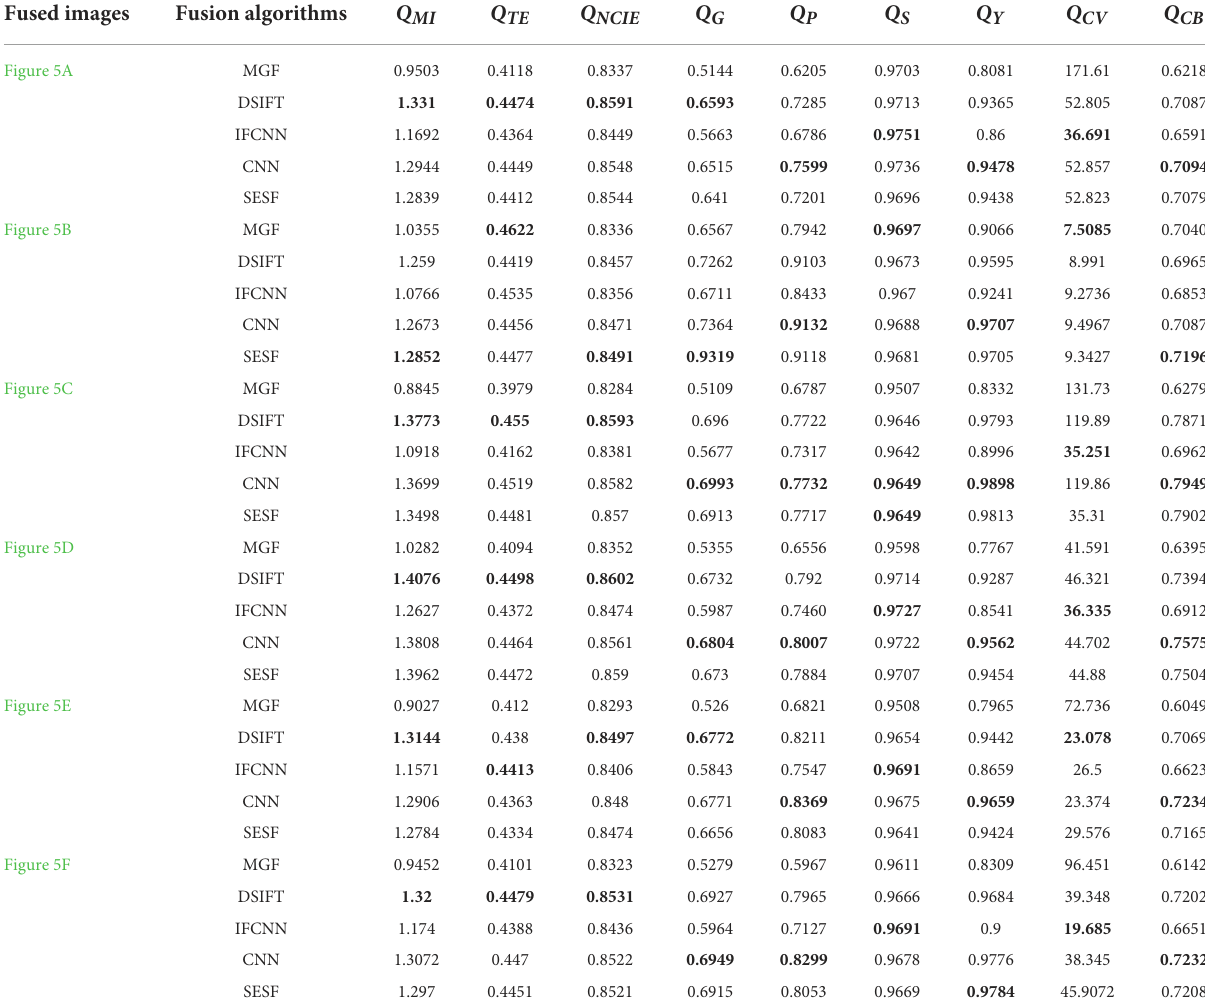
TABLE 4 The nine metrics’ values of the fused images obtained by different fusion